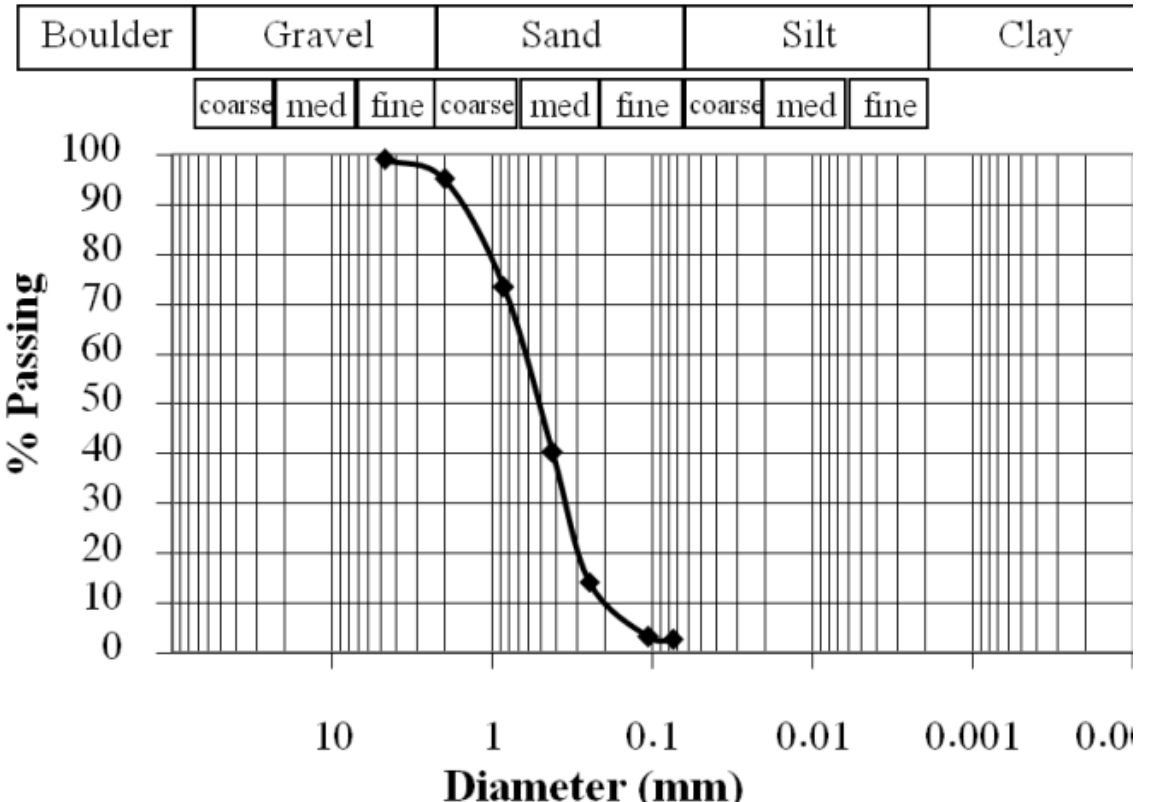
Figure 17. The sieve analysis of specimen 11 at 89.6E km at Sarapum